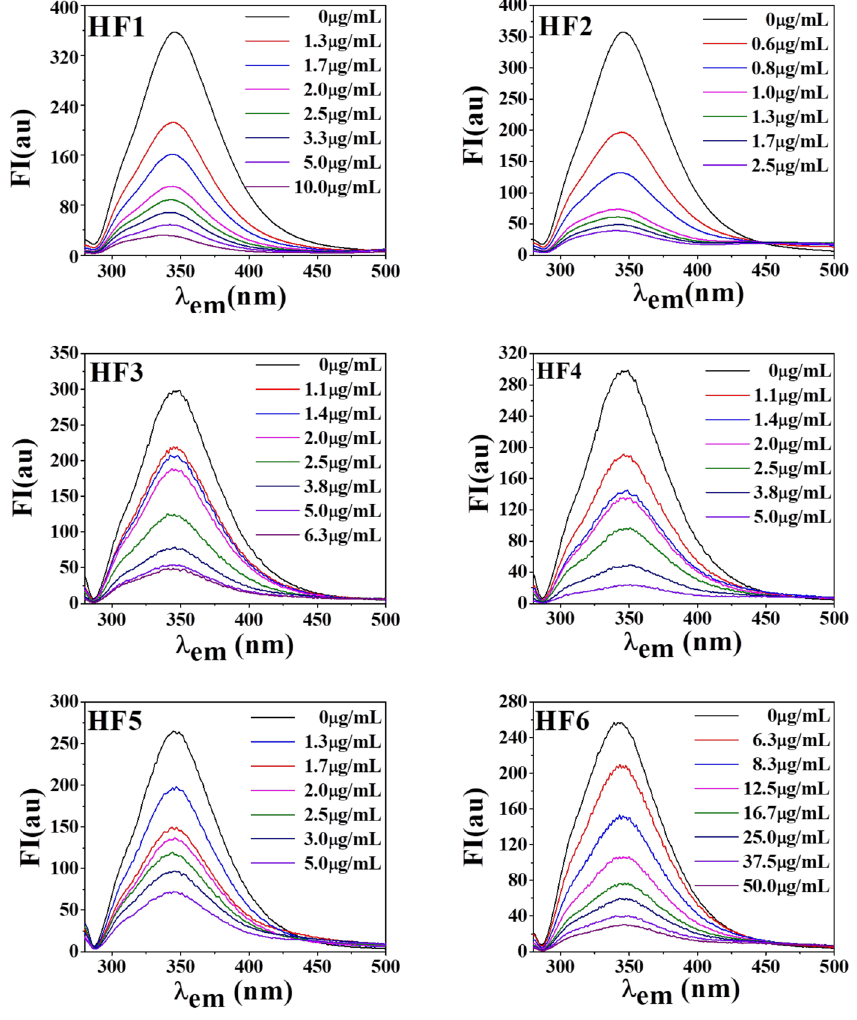
Figure 3. The two- dimensional fluorescence spectra (2D-FL) of